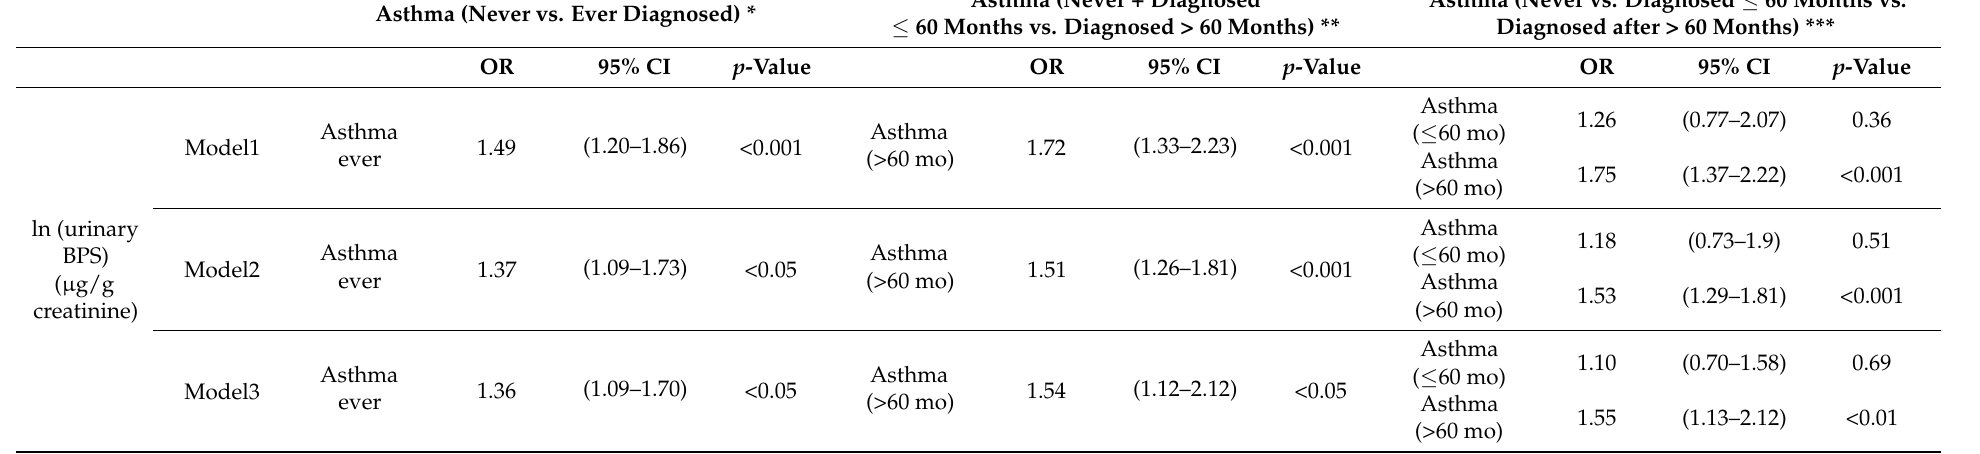
Table 3. Multivariable analysis between asthma diagnosis and urinary bisphenol